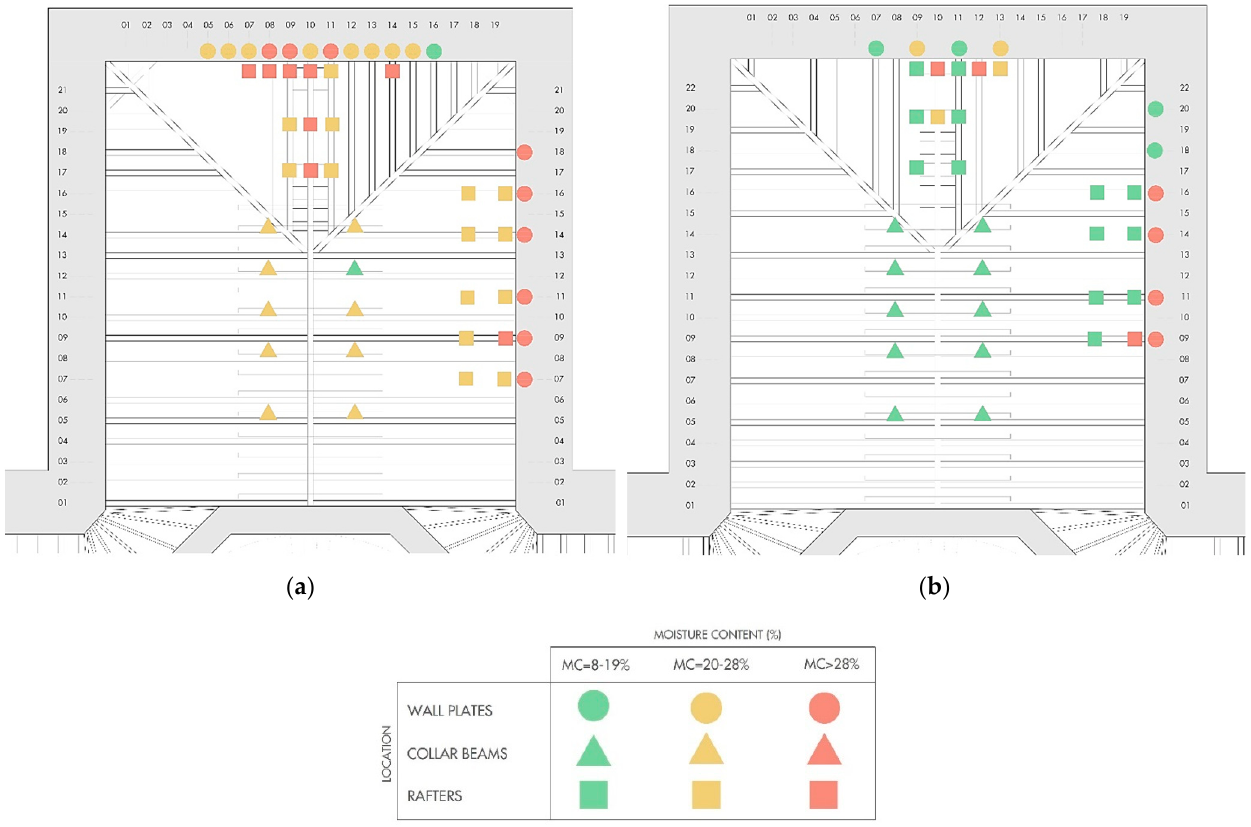
Figure 14. Results of the moisture content of the wood by electrical resistance tests: ( a ) rainy day measurement results; ( b ) sunny day measurement results.